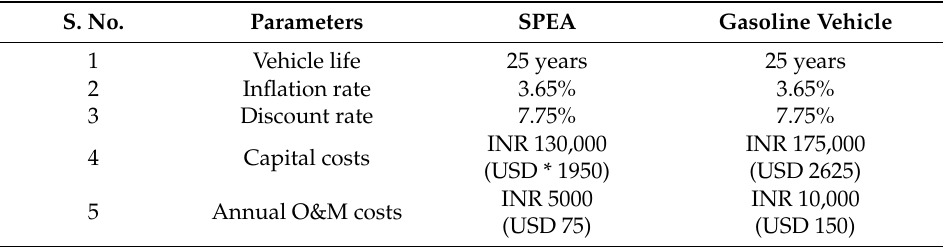
Table 3. Assumptions in cash flow analysis of SPEA and gasoline vehicle.